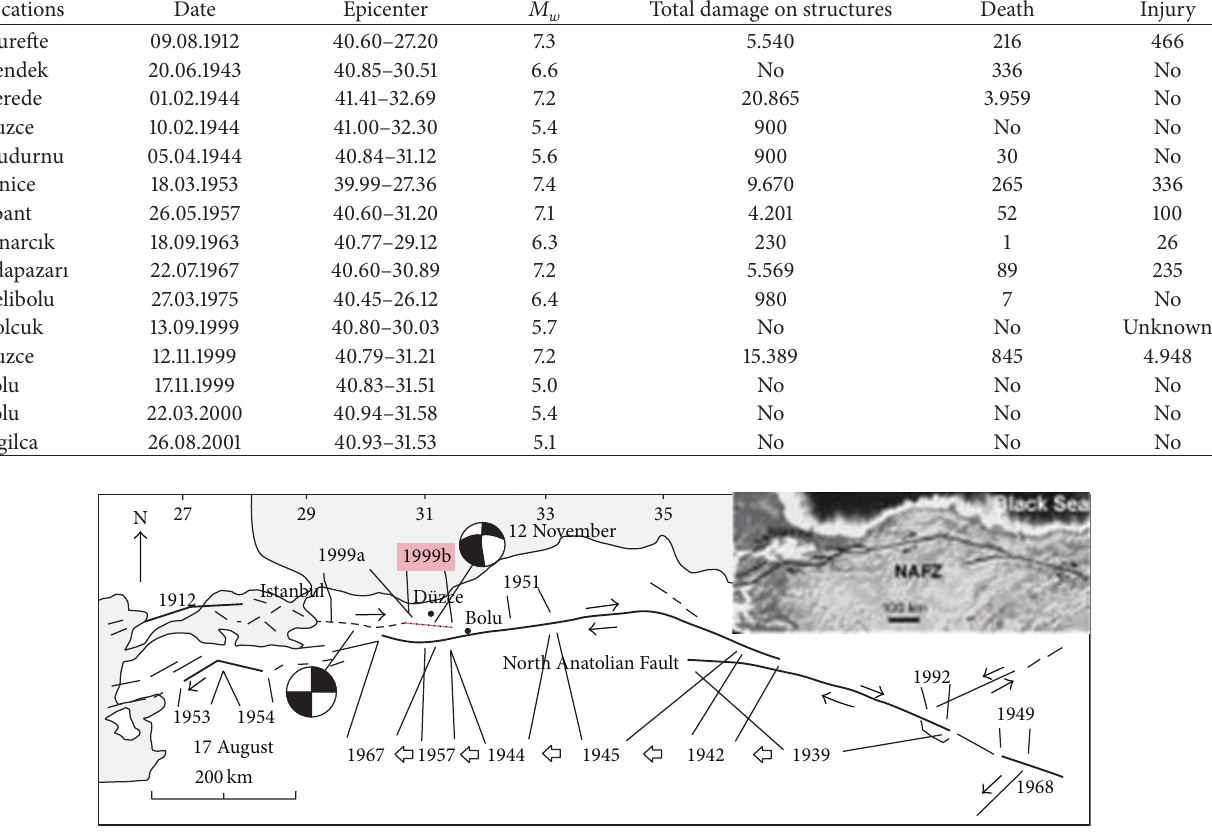
Figure 5: Epicenters of the earthquakes and historical earthquakes in the region